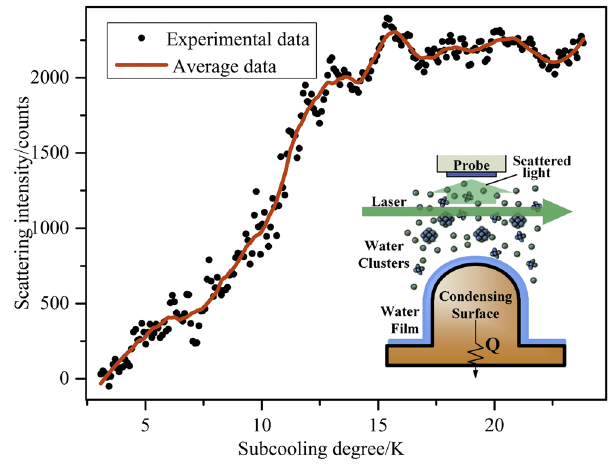
Figure 1. Clusters scattering intensity changes with subcooling degree.